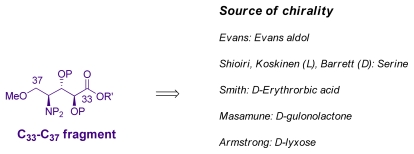
Retrosynthetic analysis of C33–C37 fragment.